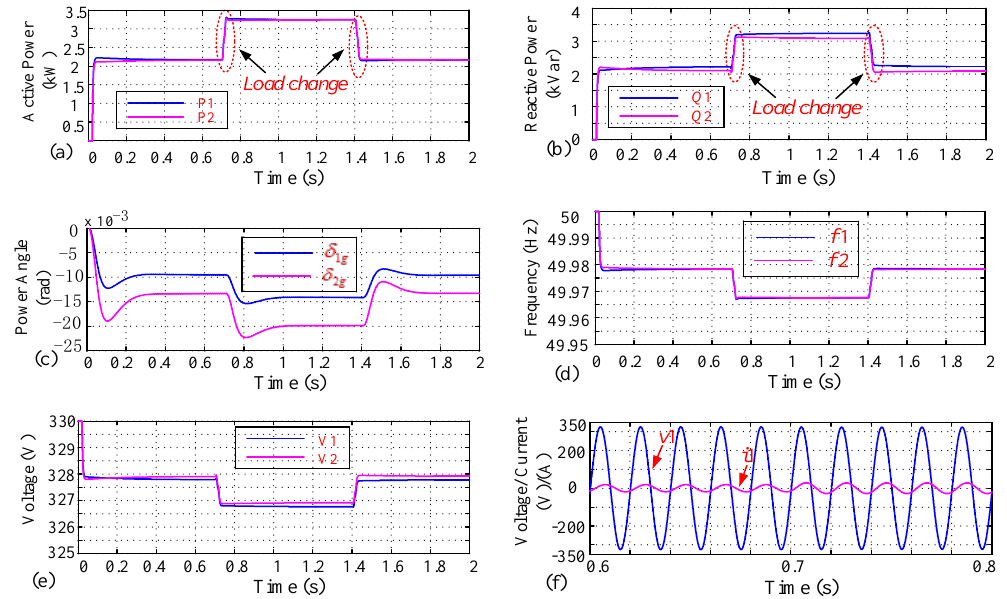
Figure 14. Simulation results in Case F: ( a ) active power; ( b ) reactive power; ( c ) power angle; ( d ) frequency; ( e ) voltage amplitude; and ( f ) voltage and current of DG1.